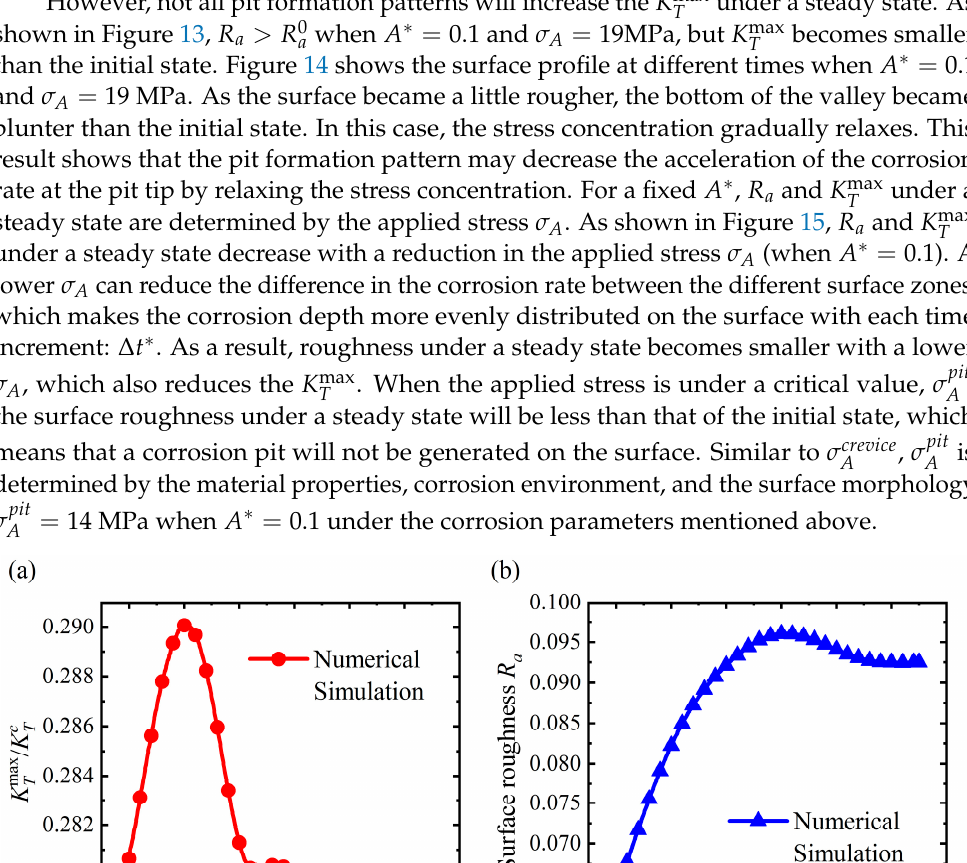
Figure 12. Evolution of ( a ) maximal stress concentration factor and ( b ) surface roughness during the corrosion when A ∗ = 0.1 and σ A = 50 MPa under a steady state. As